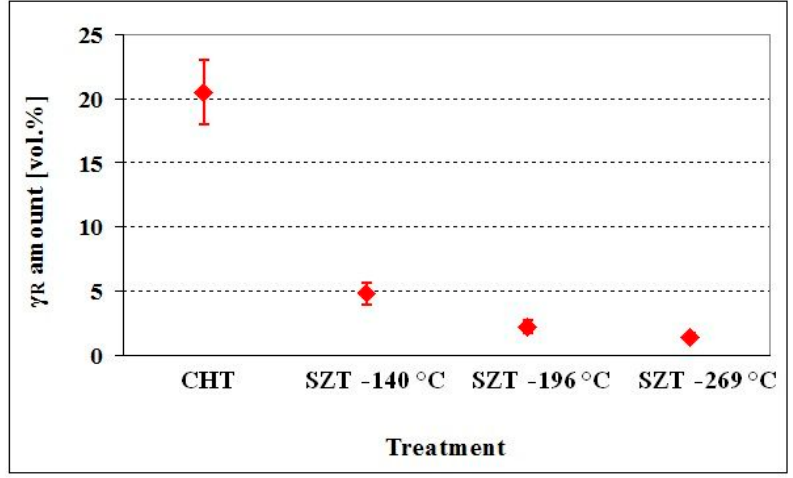
Figure 12. Retained austenite amount in CHT and differently SZT specimens after tempering at 170 °C: ( a ) CHT, ( b ) SZT at − 140 °C, ( c ) SZT at − 196 °C, and ( d ) SZT at − 269 °C.